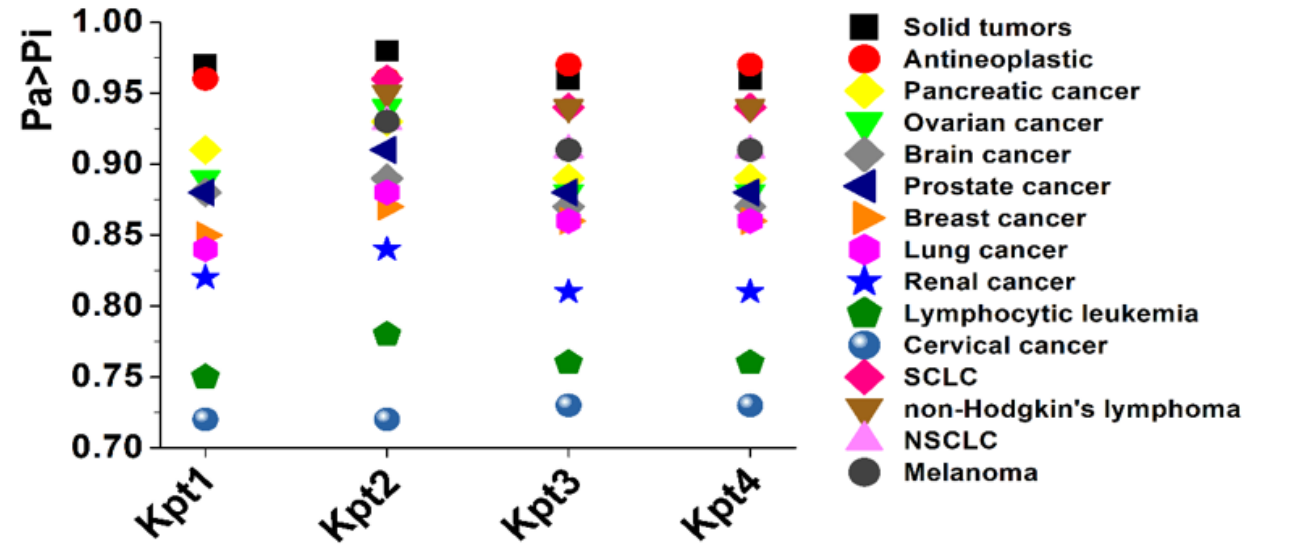
Figure 8. PASS prediction results of anticancer activity. SCLC — small cell lung cancer, NSCLC — non-small cell lung cancer.